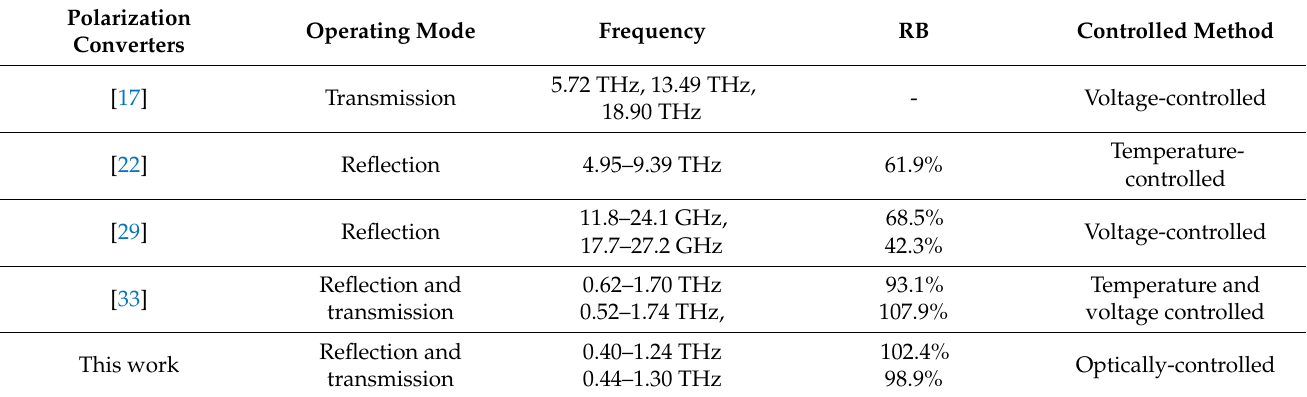
Figure 5. Schematic illustration of the conversion characteristics ( a ) Reflection mode; ( b ) Transmis- sion mode. Figures 6 and 7 show the amplitude and phase of the metasurface when the polari- zation direction of the electric field of the incident electromagnetic wave is along the u- axis and the v-axis. It can be seen from Figure 6a,b that when the metasurface works in the reflective working mode, r u and r v are approximately equal in the frequency range of 0.40–1.24 THz, and the phase difference Δ φ vu is approximately equal to 180°, indicating that the electromagnetic wave polarized along the Y-axis direction incident on the metasurface in this frequency range is converted into the reflected electromagnetic wave